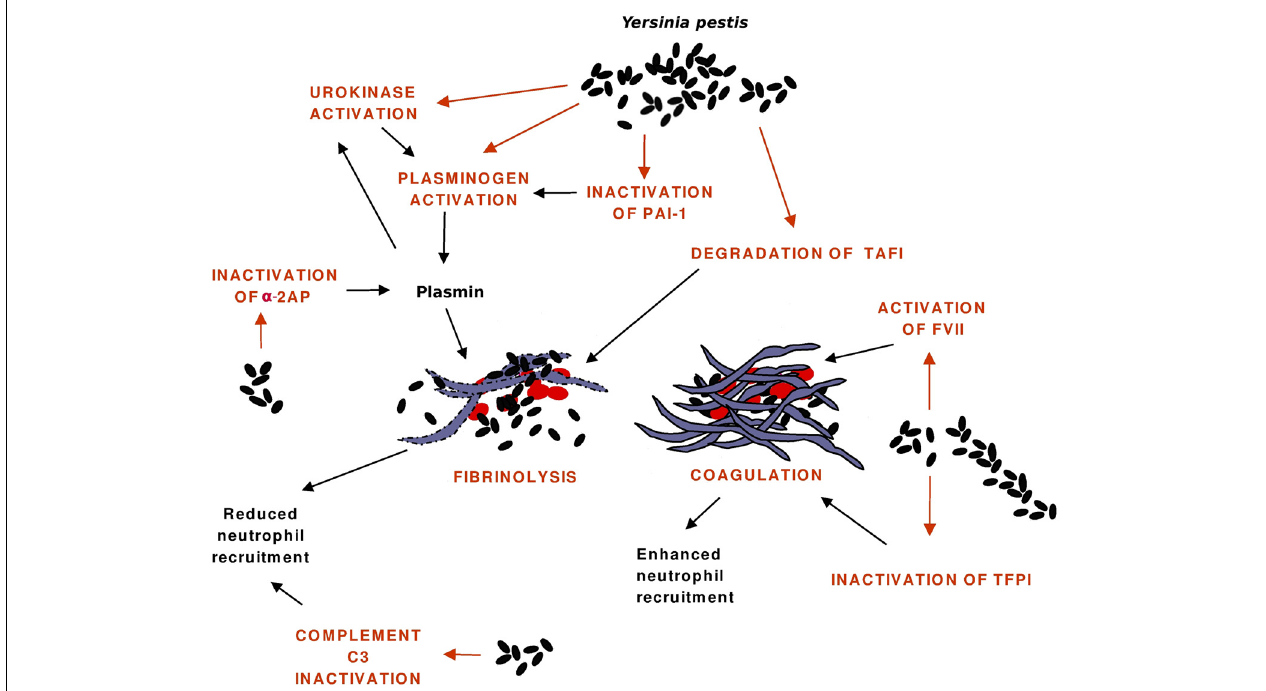
engagement of neutrophils at the infection foci, which is also affected by the Pla-mediated cleavage of the C3 complement protein. Pla favors coagulation by activating the precursor of the enzyme Factor VII (FVII) and by inactivating the anticoagulant tissue factor pathway inhibitor (TFPI). Fibrin traps bacteria and decreases their dissemination, it also increases leukocyte